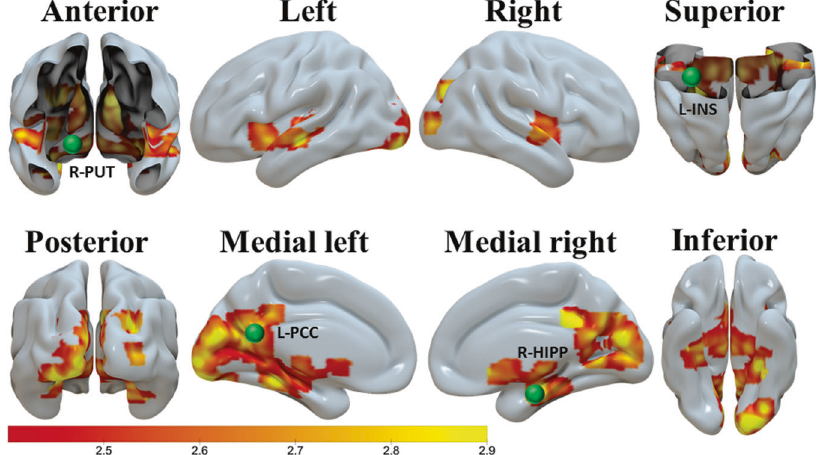
Fig. 3 The brain activation used to constrain the a priori-selected R-putamen (in anterior cut view), L-INS (in superior cut view), L-PCC (in medial left view), and R-hippocampus (in medial right view) DCM nodes. These brain activations were found by a SPM second level t -test comparison of the two genotype groups, with cluster-de fi ning threshold t = 2.4 and uncorrected two-tailed cluster level p < 0.05. This analysis found that, during the mirtazapine scan, the participants with the wild-type HTR2C exhibited greater cocaine word-elicited activation than those with the HTR2C SNP. Scale on the color bar represents voxel t values. The nodes (spheres) are larger than the exact ones for demonstration